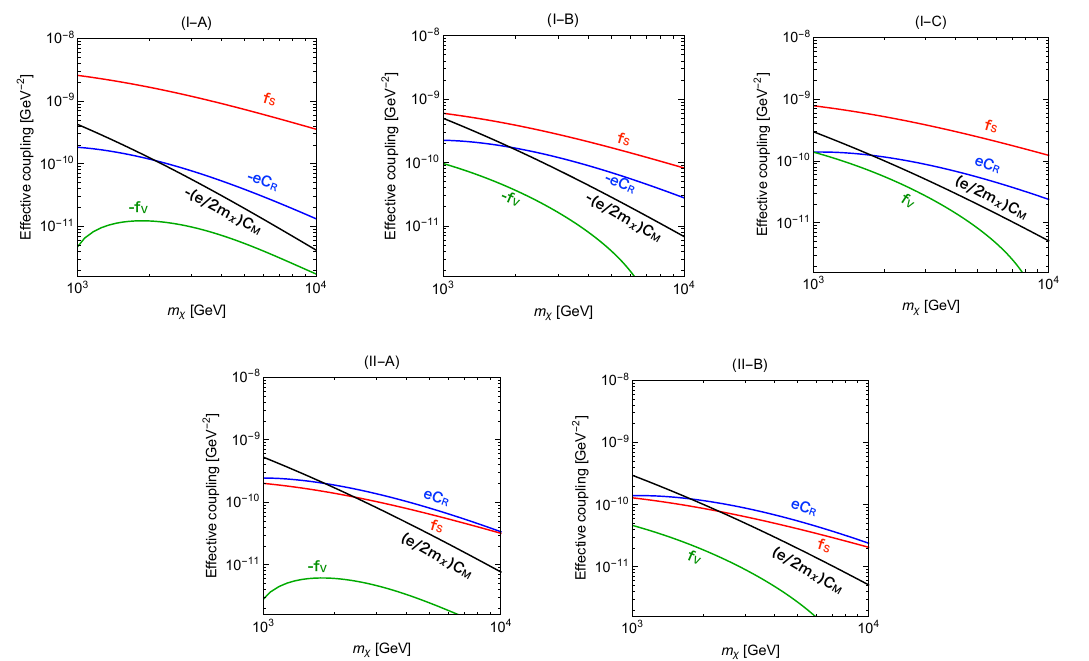
, f ( p ) , eC (cid:13) , and V S R